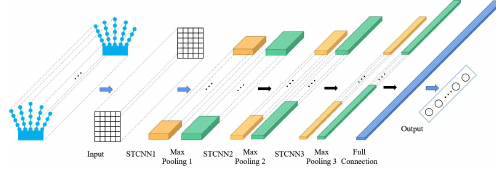
Figure 3. STCNN model